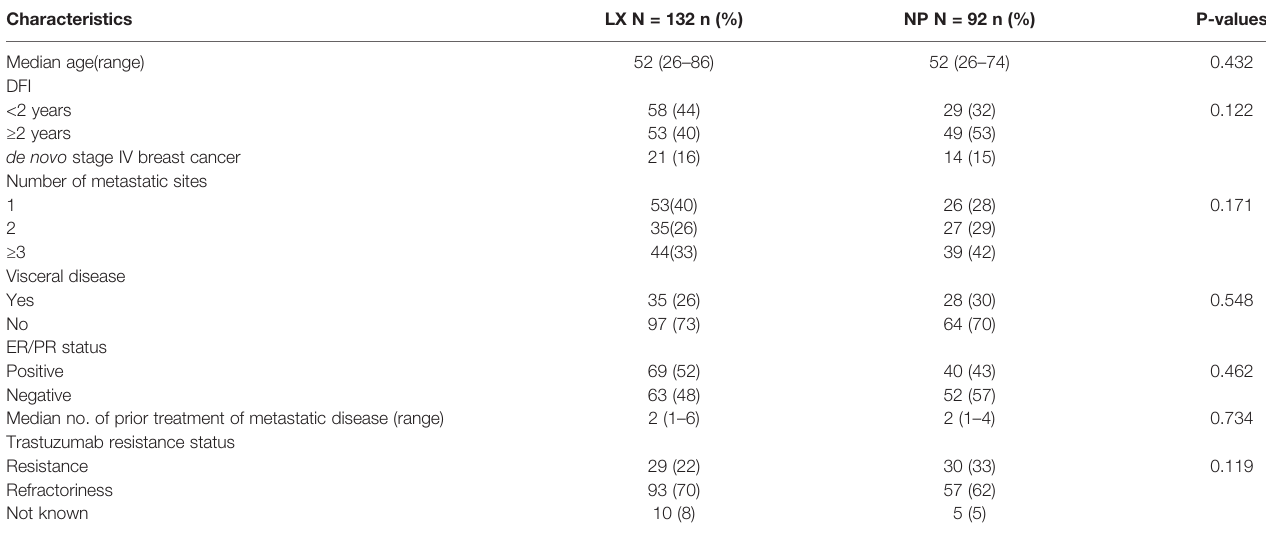
TABLE 1 | Baseline characteristics of patients grouped by LX or